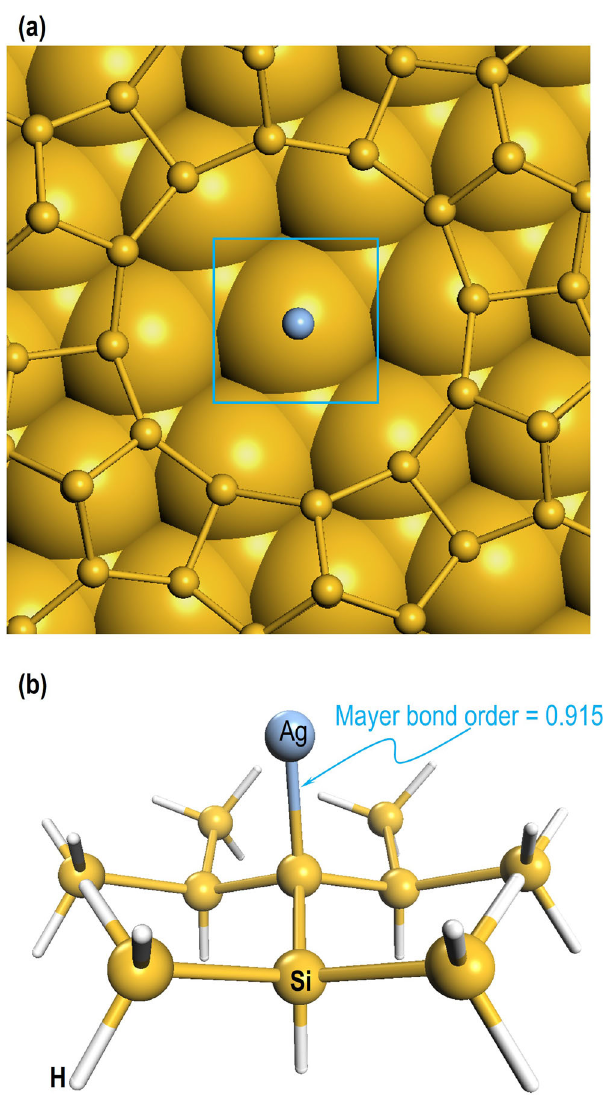
Fig. 7 Bond order between Ag-adatom and Si-atom in the CH. ( a ) The fully relaxed Ag/Si(111)-7×7 system. The blue rectangle shows the position of Ag atom in the CH and ( b ) AgSi 10 H 21 cluster model obtained from ( a ) for the calculations on Mayer bond order. The Si and Ag-atoms are represented by yellow and light blue balls and for clarity the H-atoms in ( b ) are represented by white sticks.